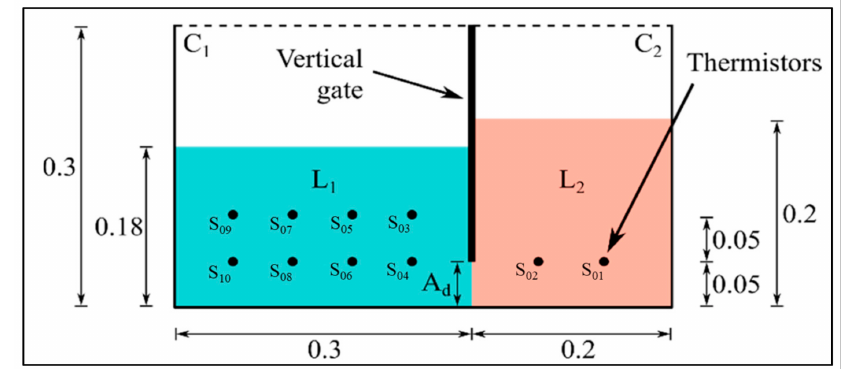
Figure 6. Computational domain and thermistors positions [32].